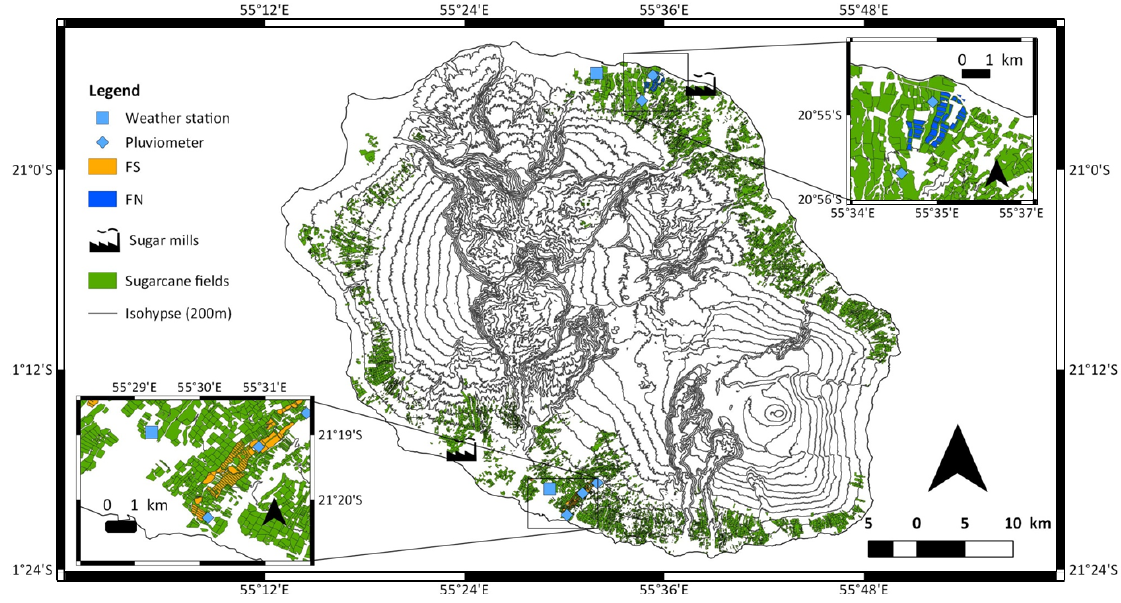
Figure 1. Location of the sugarcane fields and sugarcane mills on Reunion Island. The magnified insets show the two study sites (fields and weather and pluviometer